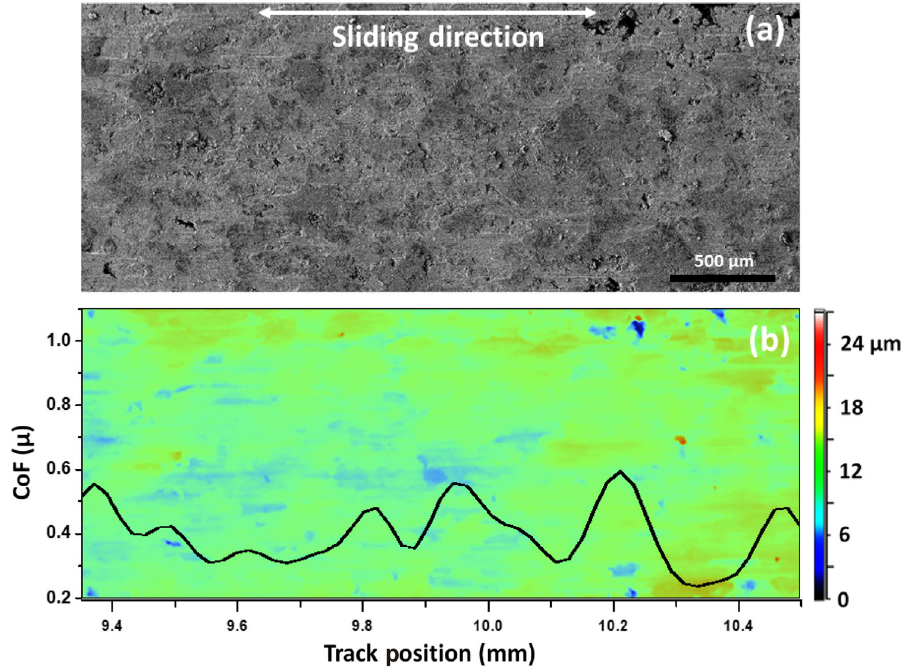
Fig. 7 Instantaneous CoF with surface profilometry indicating lower average CoF at the position where a mix of Cd and steel substrate are